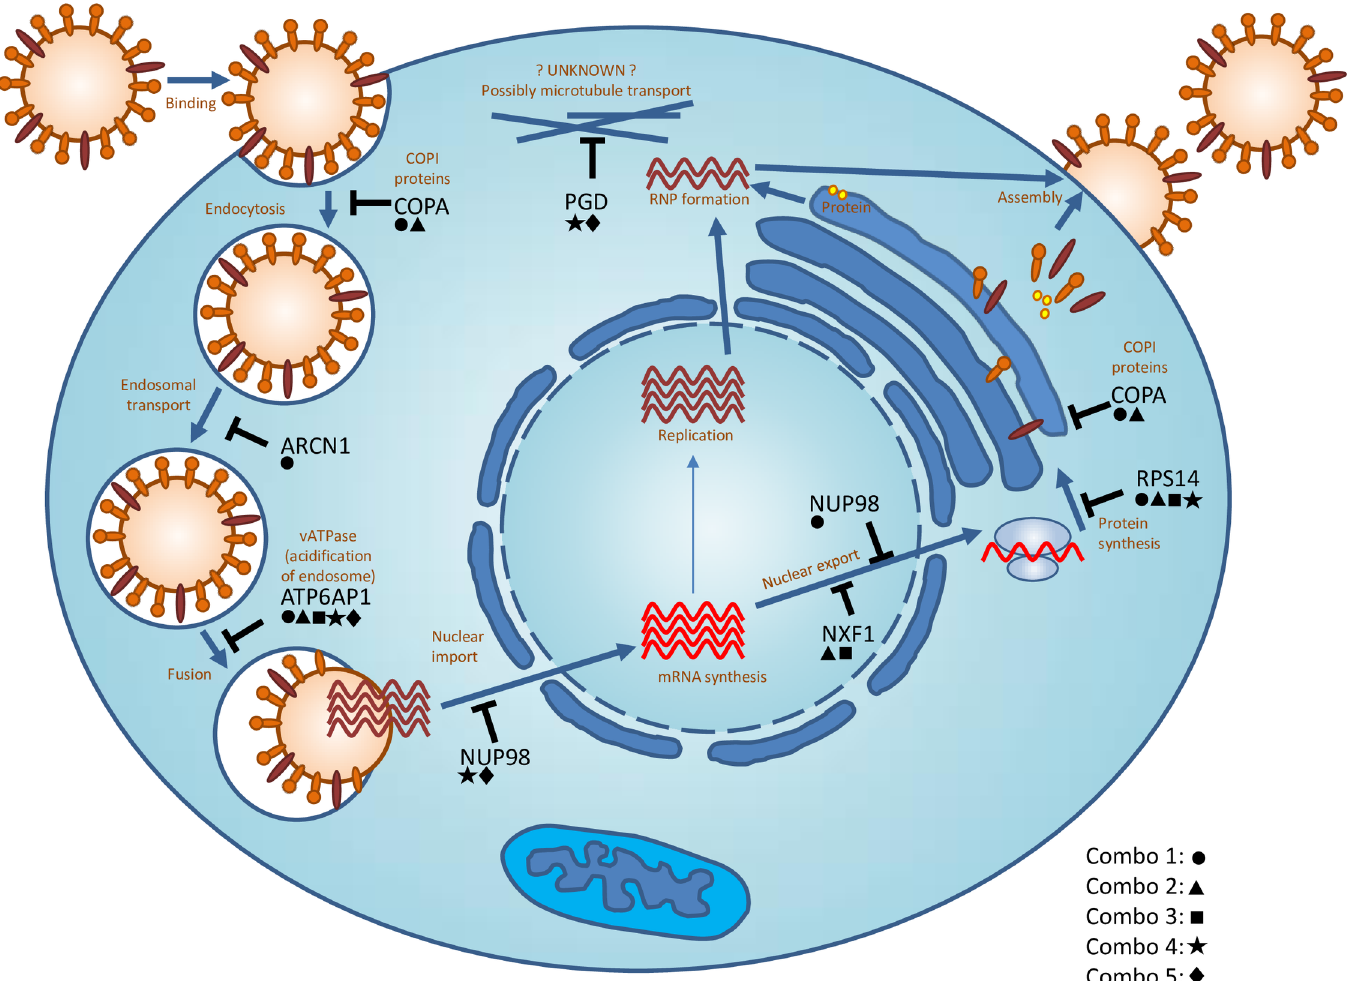
Fig 1. The activity of targeted host cell gene proteins in the influenza virus replication cycle. A schematic diagram showing the replication cycle of influenza virus and host genes required for influenza at different stages of the life cycle. The host genes targeted in this study are shown in black and the related part of the life cycle is shown in red. Five combinations were tested in addition to single knockdowns; the genes within each combo are denoted by symbols: combo1 (circle), combo2 (triangle), combo3 (square), combo4 (star), combo5 (diamond).